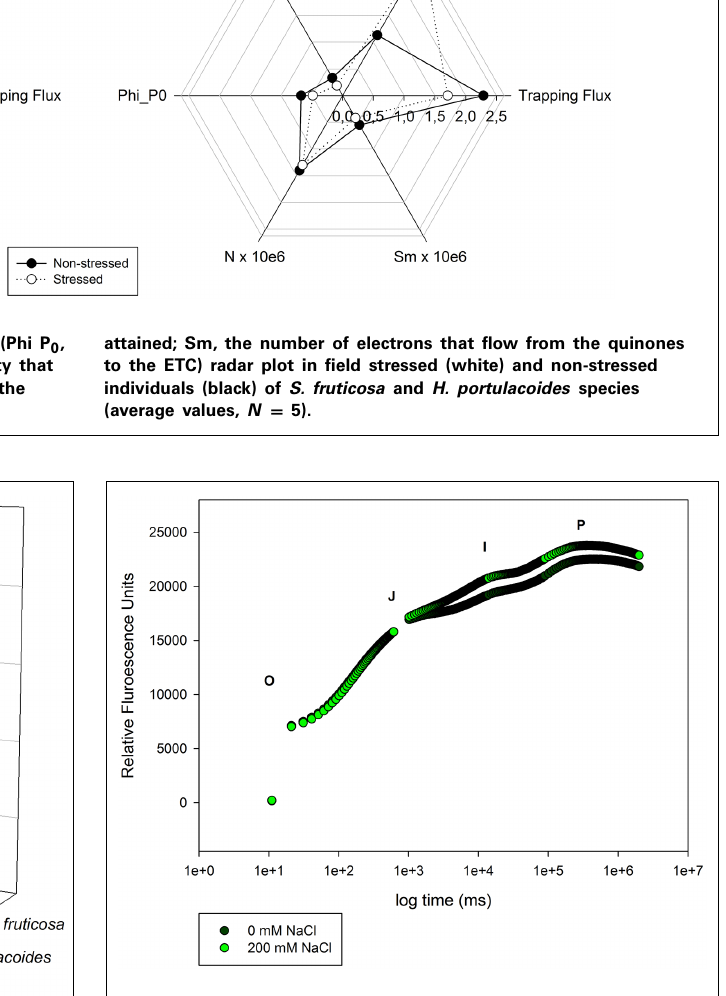
FIGURE 8 | Kautsky curve from T. gallica individuals exposed to 0 and 200 mM NaCl, during 20 days (average values, N =